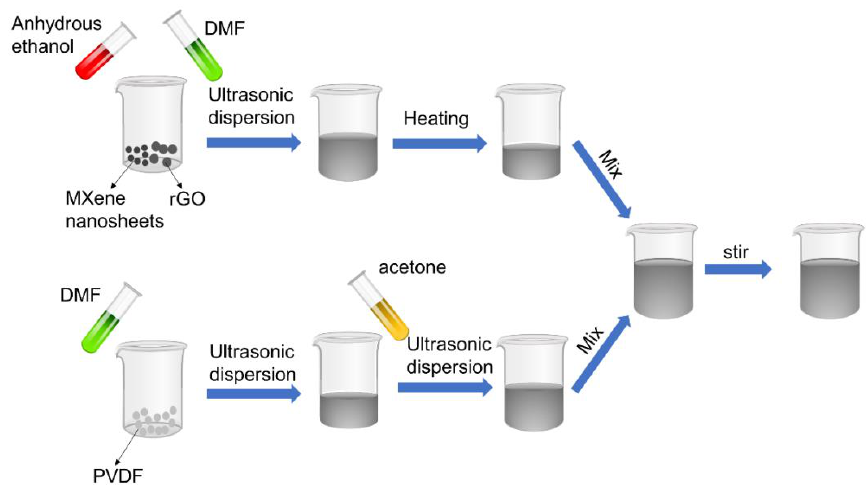
Figure 1. The preparation process of the PMR nanocomposite printing